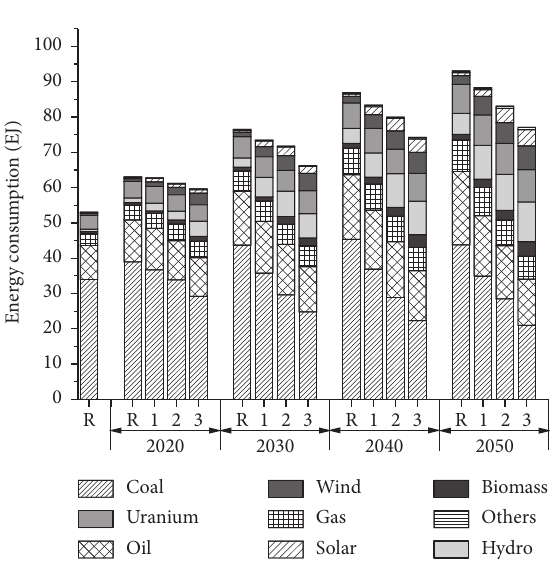
Figure 4: Primary energy consumption and